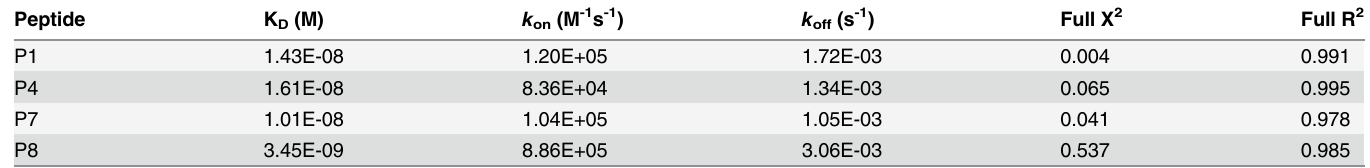
Table 3. Kinetic Rate Constants And Affinities Of Peptide Binding To Purified APP Ectodomain Using Streptavidin Biosensors. Peptide K D (M) k on (M -1 s -1